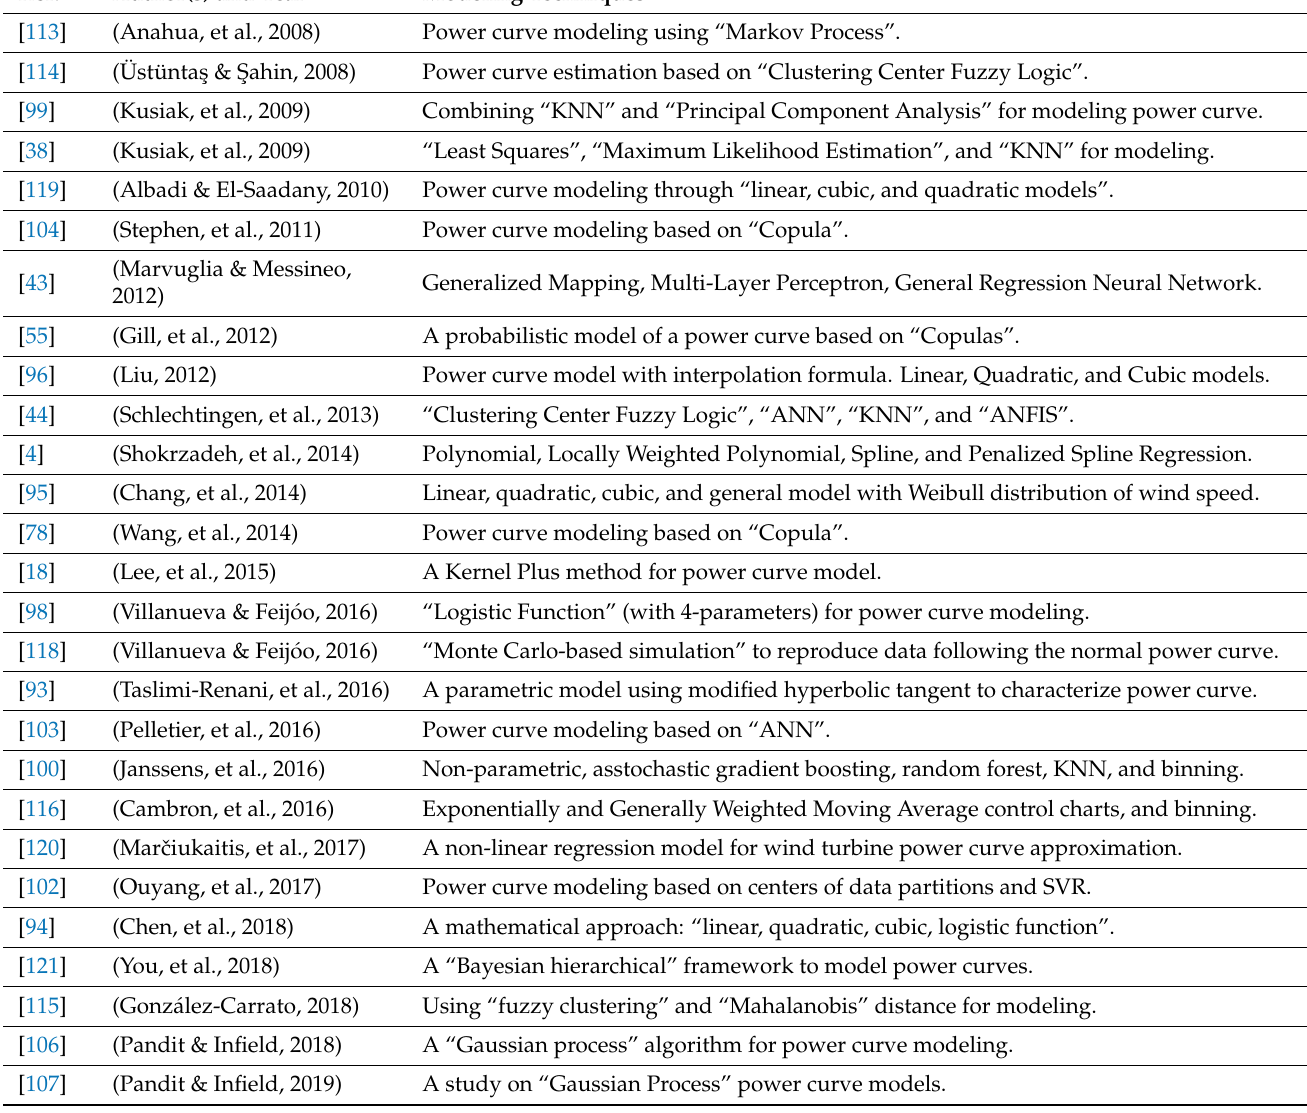
Table 7. Research articles on parametric and non-parametric